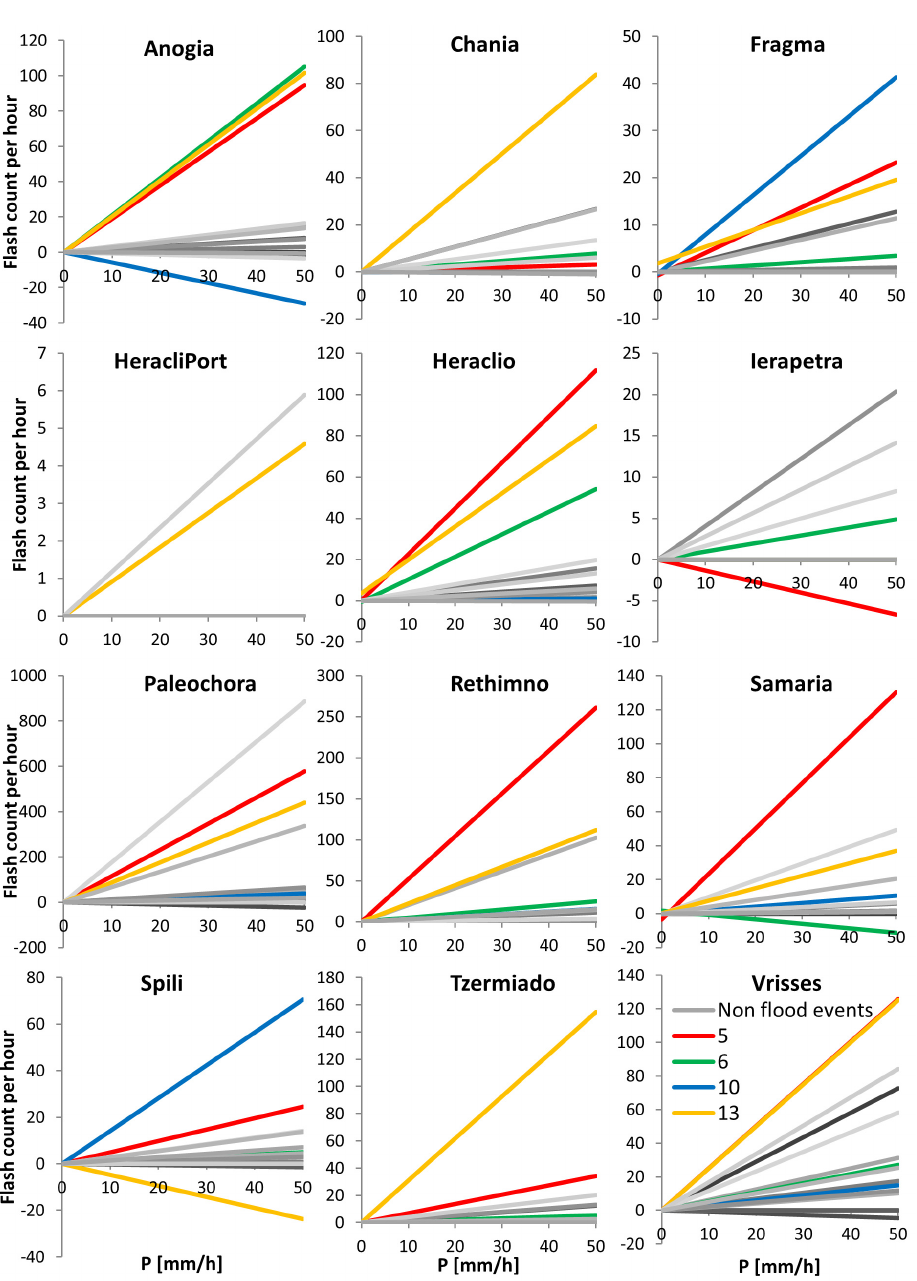
Fig. 4. Regression lines of maximum attained coefficient of determination at specific radius and time lag per station for the sixteen events. Non flood events marked in grey and flood events are marked in